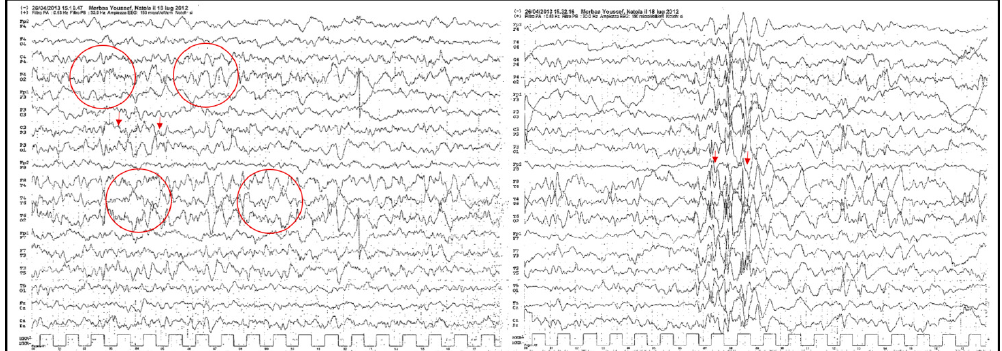
Figure 2. Electroencephalography (EEG): interictal hypsarrhythmia. Slow high voltage of delta and theta activity (circles on the left), mono/polymorphic preceded by multifocal PO (arrows on the left), PPO spike (arrows on the right).